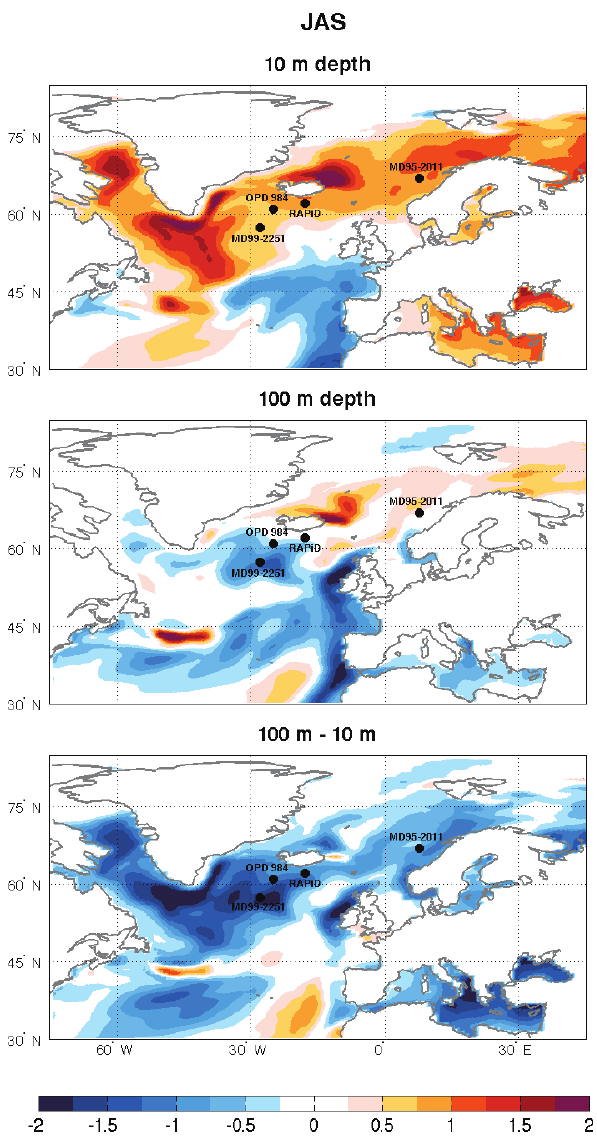
Fig. 10. 6k-0k CCSM3 model result for winter (JFM) temperature for 10m and 100m as well as the 6k-0k anomaly for the difference between 100m and